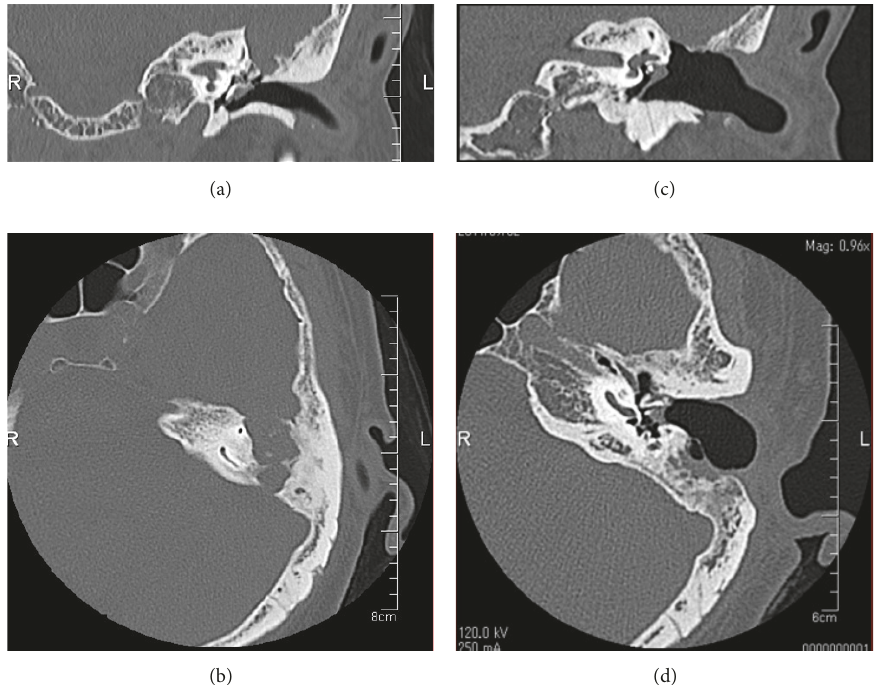
Figure 2: (a) Coronal CT of the temporal bone showing bony destruction of the middle cranial fossa. (b) Axial CT showing bony destruction of the middle and posterior cranial fossae. (c, d) Postoperative CT at 3 years after the operation shows no recurrence of cholesterol